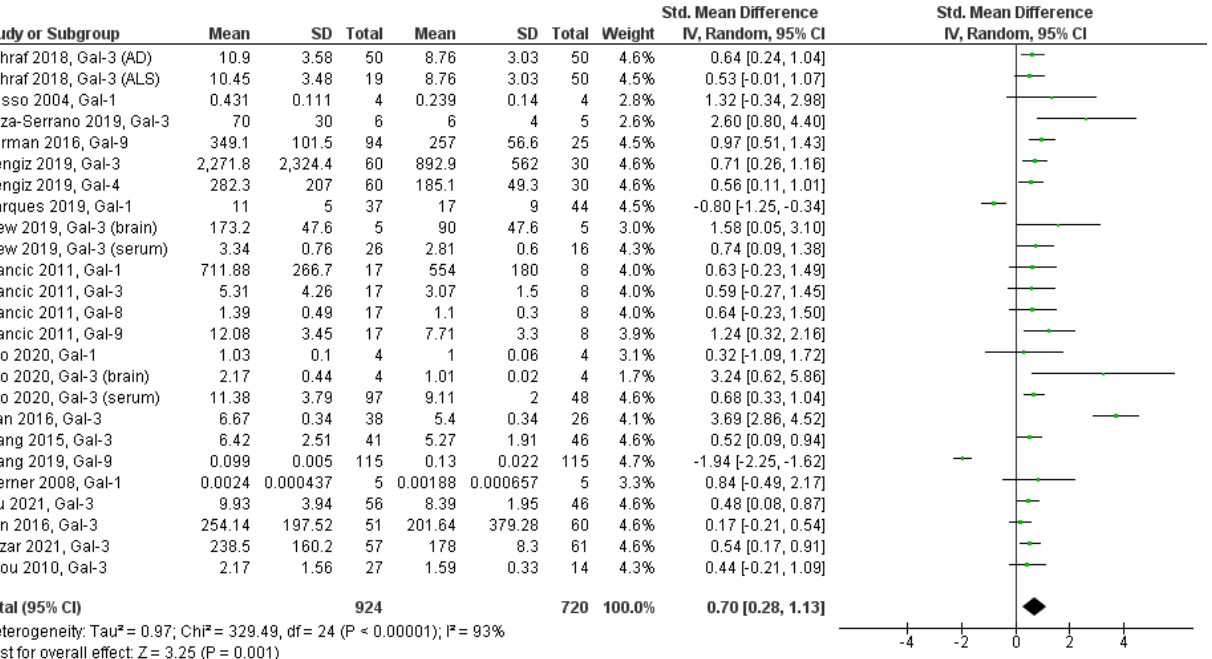
Figure 2. Forest plot showing the results of the meta-analysis of random effects of galectin levels in patients with neurodegenerative diseases and healthy individuals.